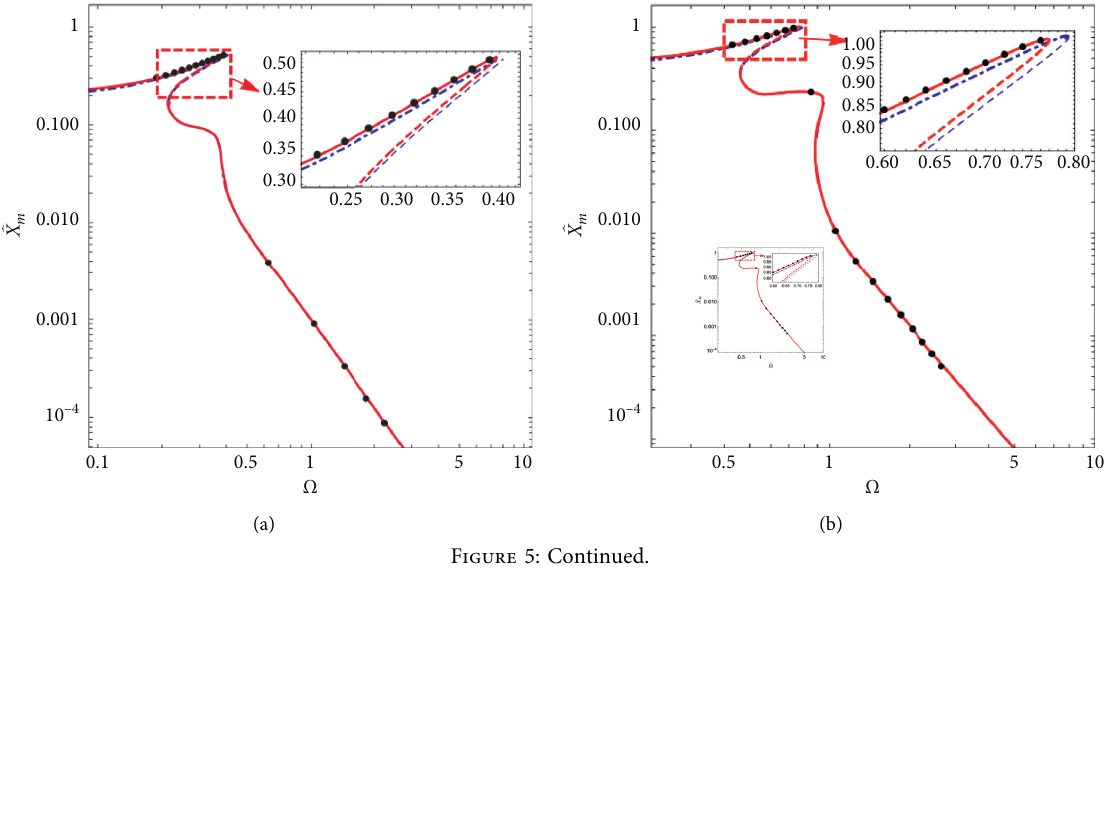
� 0 . 2, ζ � ζ � 0 . 01, ζ v 1 v 2 � 10, respectively. Dashed-dotted e